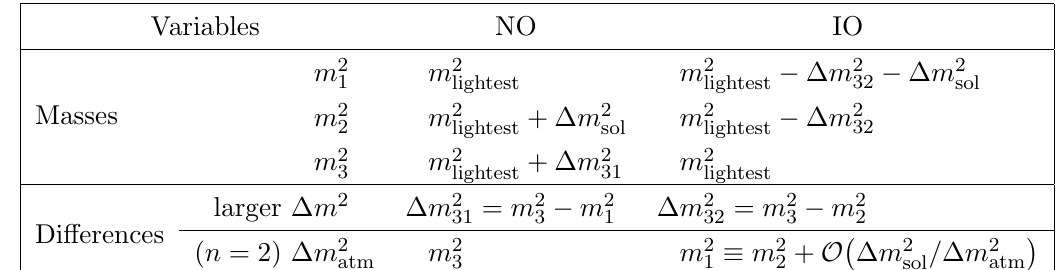
Table 1. De(cid:12)nitions of the neutrino masses and their di(cid:11)erences, for \normal ordering" (NO) and \inverted ordering" (IO). The smaller mass di(cid:11)erence ("solar mass di(cid:11)erence") is given by (cid:1) m 2 = m 2 (cid:0) m 2 for both hierarchies, while the larger mass di(cid:11)erence is hierarchy depended. For 2 1 sol historical reasons one also de(cid:12)nes the \atmospheric mass di(cid:11)erence" (cid:1) m 2